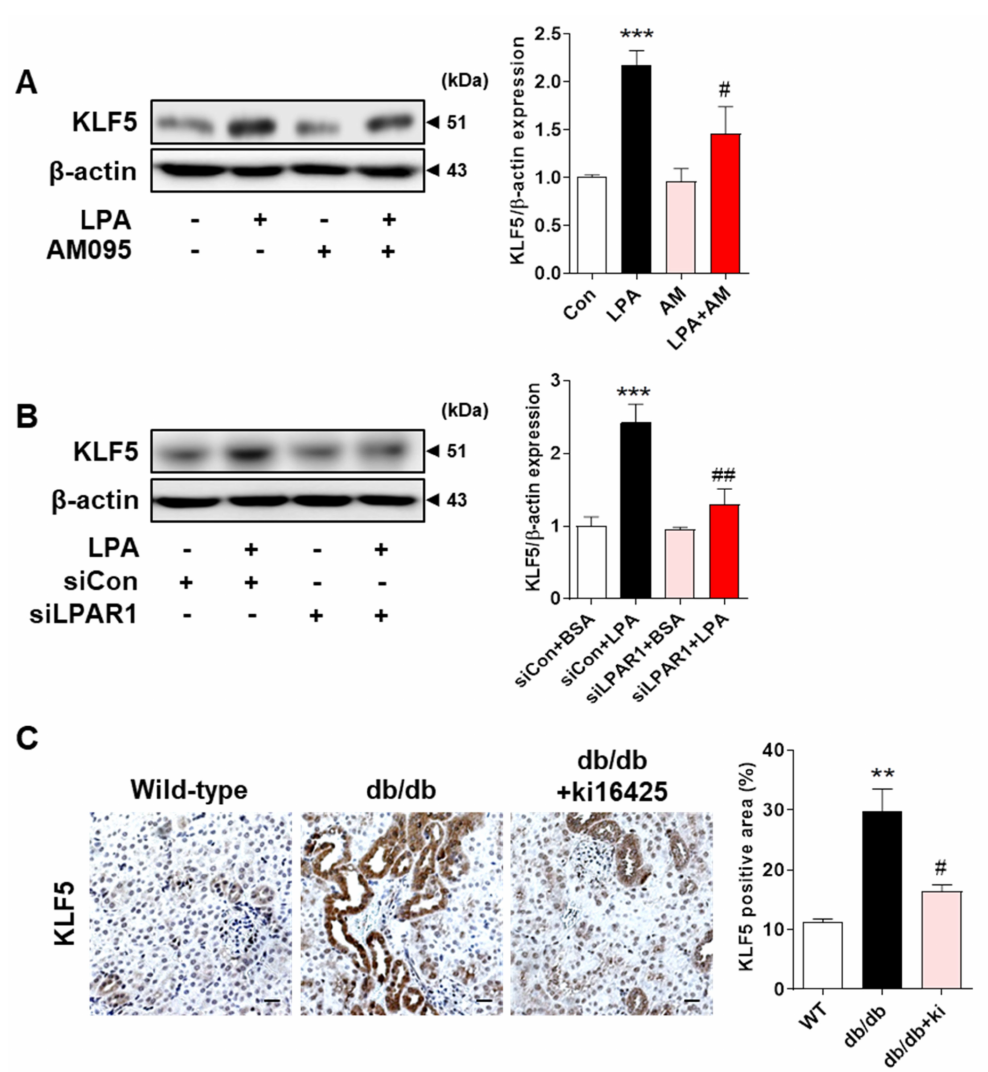
Figure 4. LPA induced KLF5 expression via LPAR1 in HK-2 cells and db/db mice. ( A ) HK-2 cells were treated with 20 µ M LPA in the presence or absence of 10 µ M AM095 for 30 min. ( B ) HK- 2 cells were transfected with a control siRNA (siCon) or LPAR1 siRNA (siLPAR1) and treated with 20 µ M LPA for 30 min. ( A , B ) Protein levels of KLF5 were analyzed via Western blotting, quantified using ImageJ software, and normalized to that of β -actin. Representative images (left) and quantitative analysis bar graphs (right) are shown ( n = 3 independent experiments). Data are presented as the mean ± SEM. *** p < 0.005 vs. Con or siCon+BSA; # p < 0.05, ## p < 0.01 vs. LPA or siCon+LPA. ( C ) The animal experiments are described in the Materials and Methods section. Immunohistochemical detection of KLF5 was performed in the kidney tissues using DAB. The nuclei were counterstained with hematoxylin. The positive expression area of KLF5 was quantified using ImageJ software. Representative images (left) and quantitative analysis bar graph (right) are shown. Original magnification, 200 × ; scale bars, 20 µ m; n = 3 mice per group. Data are presented as the mean ± SEM. ** p < 0.01 vs. wild-type (WT); # p < 0.05 vs.